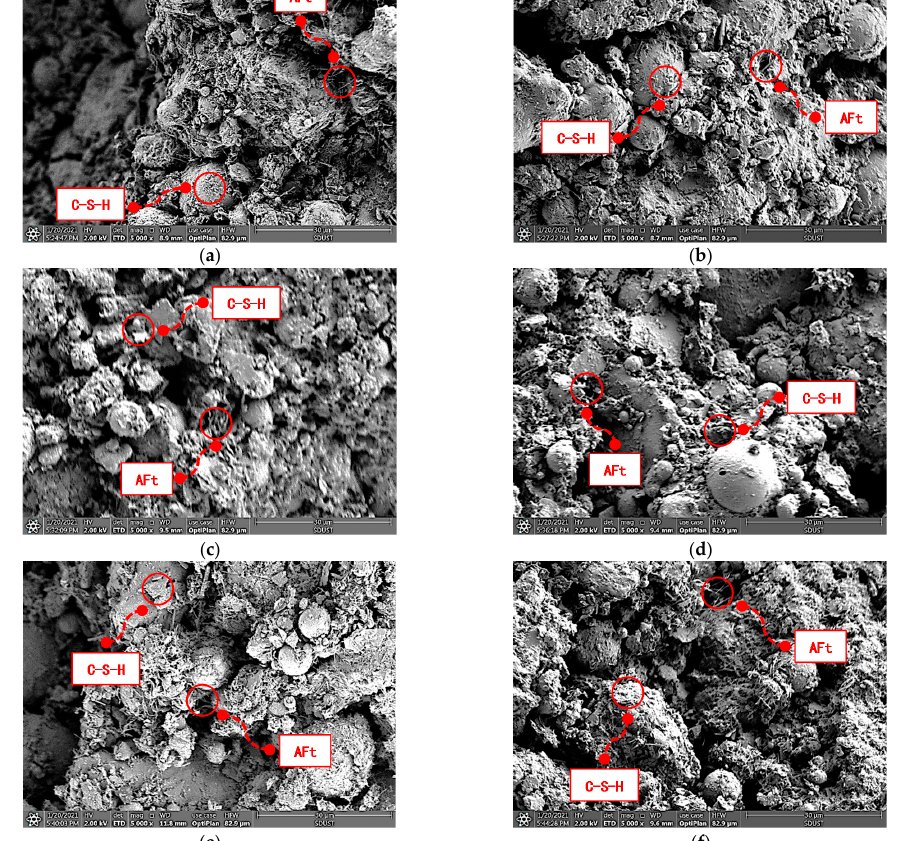
Figure 9. SEM image of fracture surface of CGFB samples. ( a ) 0% CP; ( b ) 10% CP; ( c ) 20% CP; ( d ) 30% CP; ( e ) 40% CP; ( f ) 50% CP. PCAS is a professional software tool for the identification and quantitative analysis of pore systems and fracture systems [36]. It can automatically identify all types of pores and fractures in images and obtain all geometric and statistical parameters. Concerning pore recognition, it can import various pore images, remove clutter automatically, seg- ment and recognize pores automatically through binarization, output the geometric and